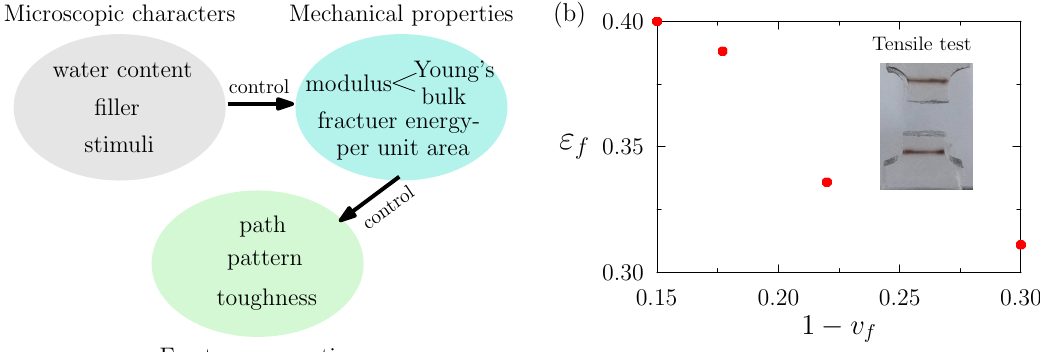
Figure 2. ( a ) Tuning the fracture property by microscopic characters such as water content, filler or stimuli for hydrogels. ( b ) Results of tensile fracture test for a brittle hydrogel (fracture strain vs. water volume